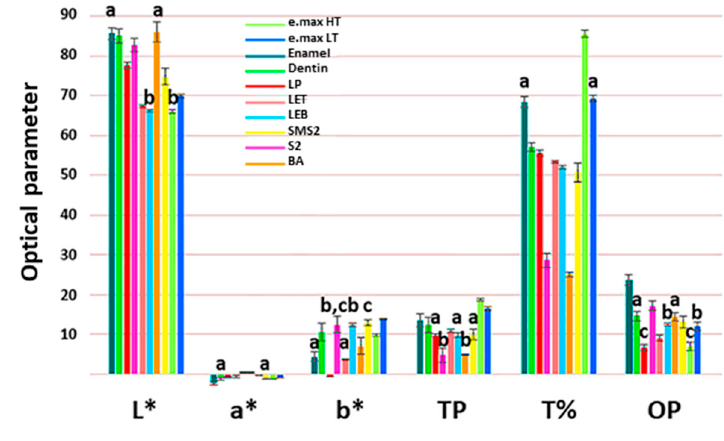
Figure 1. Optical parameters of CIE L *, a *, and b * against an A2 background, TP, T% at 550 nm, and opalescence parameter (OP) of each group. Means with the same superscript letter in each column are not significantly di ff erent from each other based on Tukey’s multiple comparison test ( p > 0.05). Di ff erences in the reflectance under di ff erent UV illumination conditions are shown in Figure 3. Bovine dentin exhibited highest fluorescence value. Bovine dentin, enamel, LET, and LEB showed fluorescence and the peak wavelength was 430